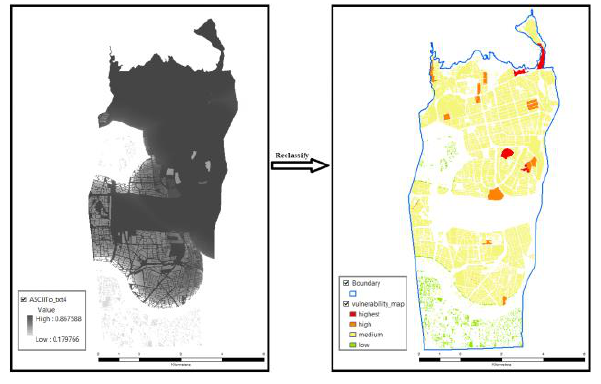
Figure 12. Vulnerability